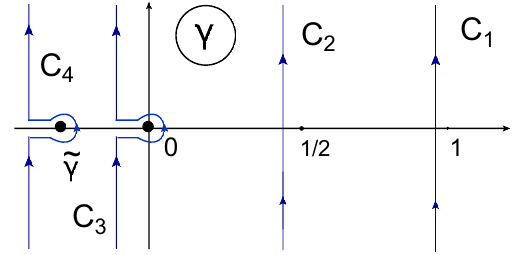
Fig. 2 The contours of integration over γ